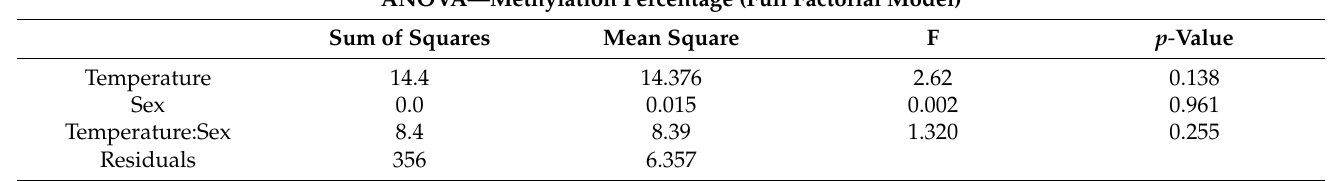
Table 1. ANOVA results for absorbance and percent 5-mC DNA methylation values measured by ELISA in the tail of Chrysemys picta hatchling tail tissue. ANOVA—Methylation Percentage (Full Factorial